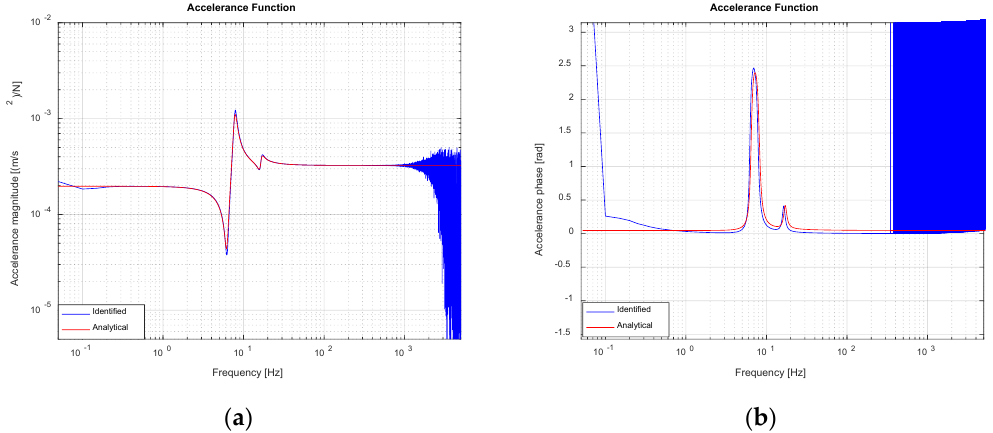
Figure 8. Identified and analytical AF (noise-free scenario): ( a ) Magnitude; ( b ) Phase.